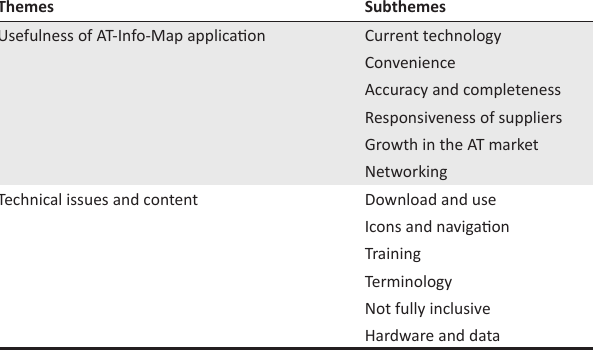
TABLE 3: Themes and subthemes from the data. Themes